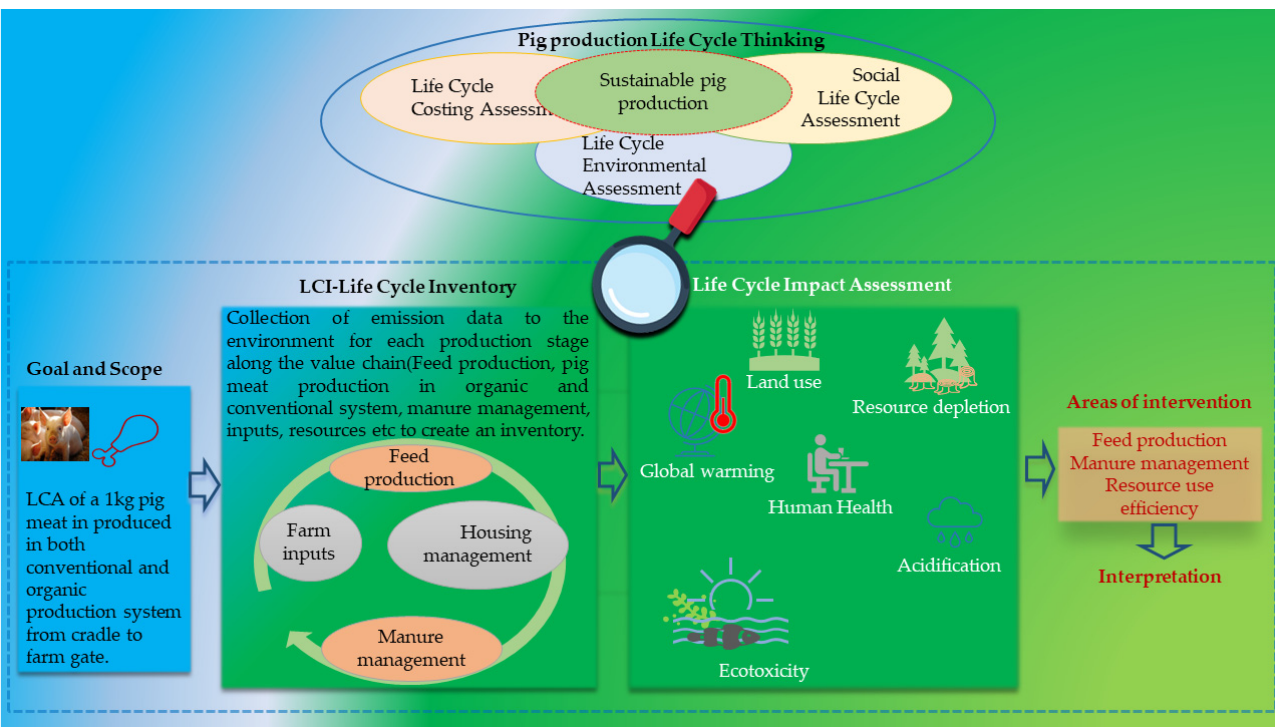
Figure 1. Methodological diagram with both the concept and the steps for Life cycle Assessment applied in evaluating pig production; as addressed by the study: Authors constructed the image using Microsoft MS Office, free to use images and icons.